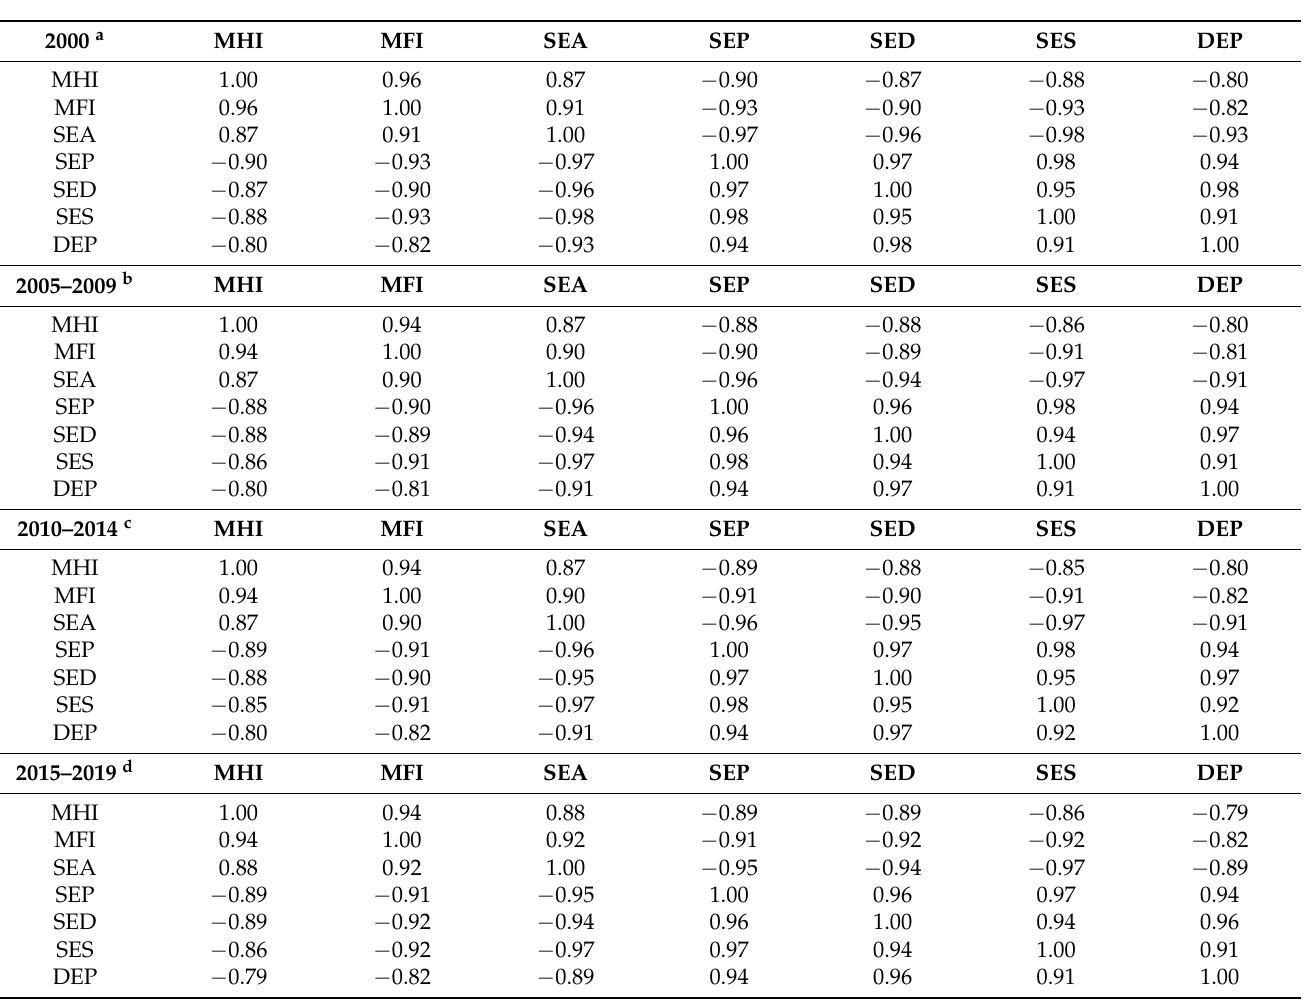
Table 4. Relationships between simple and composite measures of neighborhood socioeconomic status in the Los Angeles–Long Beach–Anaheim Metropolitan Statistical